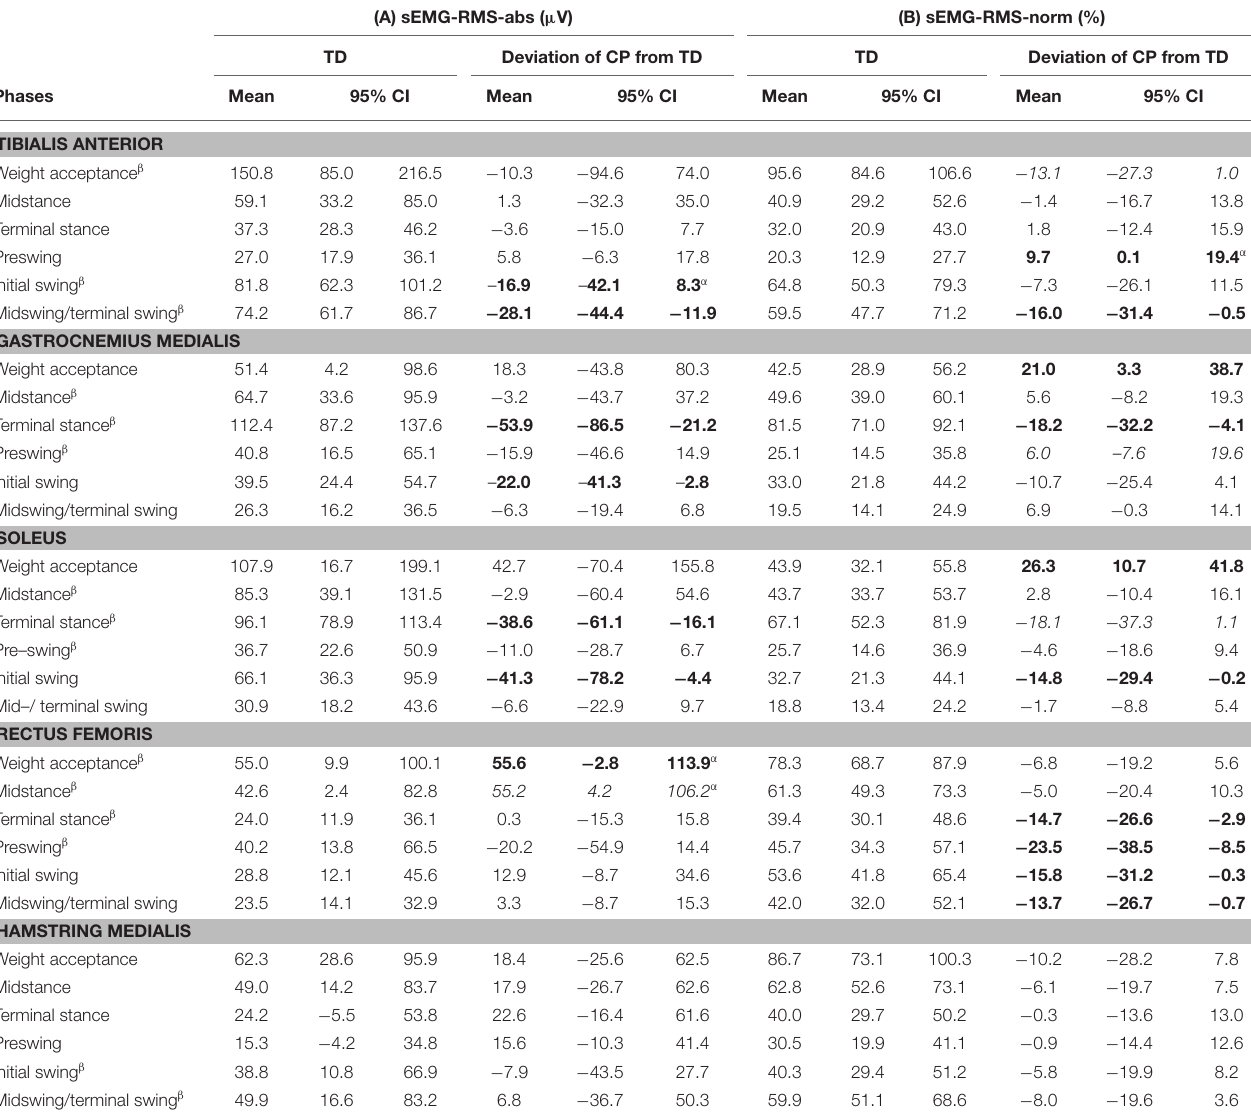
TABLE 3 | Muscle activity for healthy legs of typically developing children (TD) during six gait phases and the deviation of the affected legs of children with cerebral palsy (CP) from TD, presented as mean with 95% confidence interval